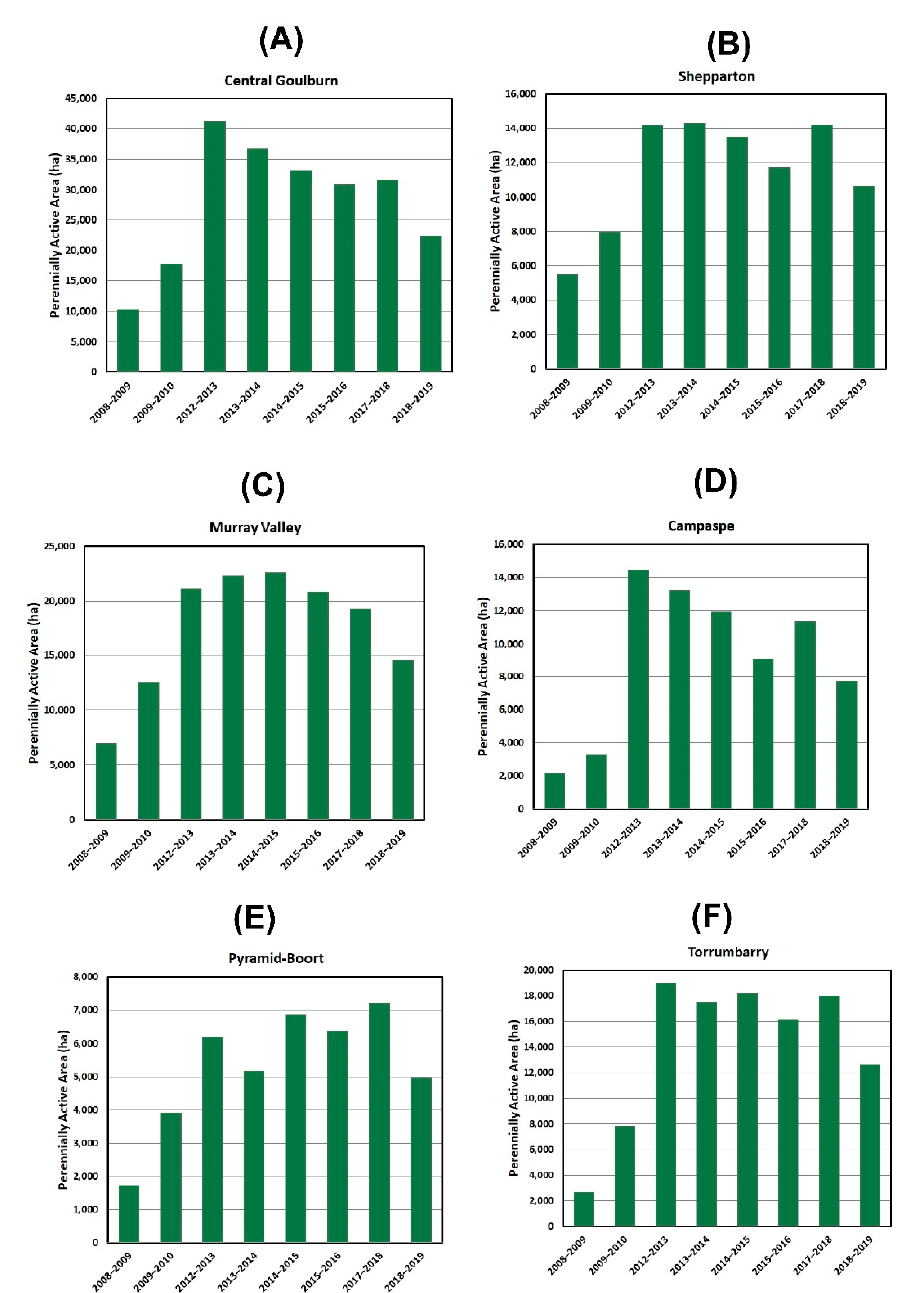
Figure 9. Temporal changes in the Perennially Active class of irrigated land cover. ( A ) Central Goulburn; ( B ) Shepparton; ( C ) Murray Valley; ( D ) Campaspe; ( E ) Pyramid-Boort; and ( F )